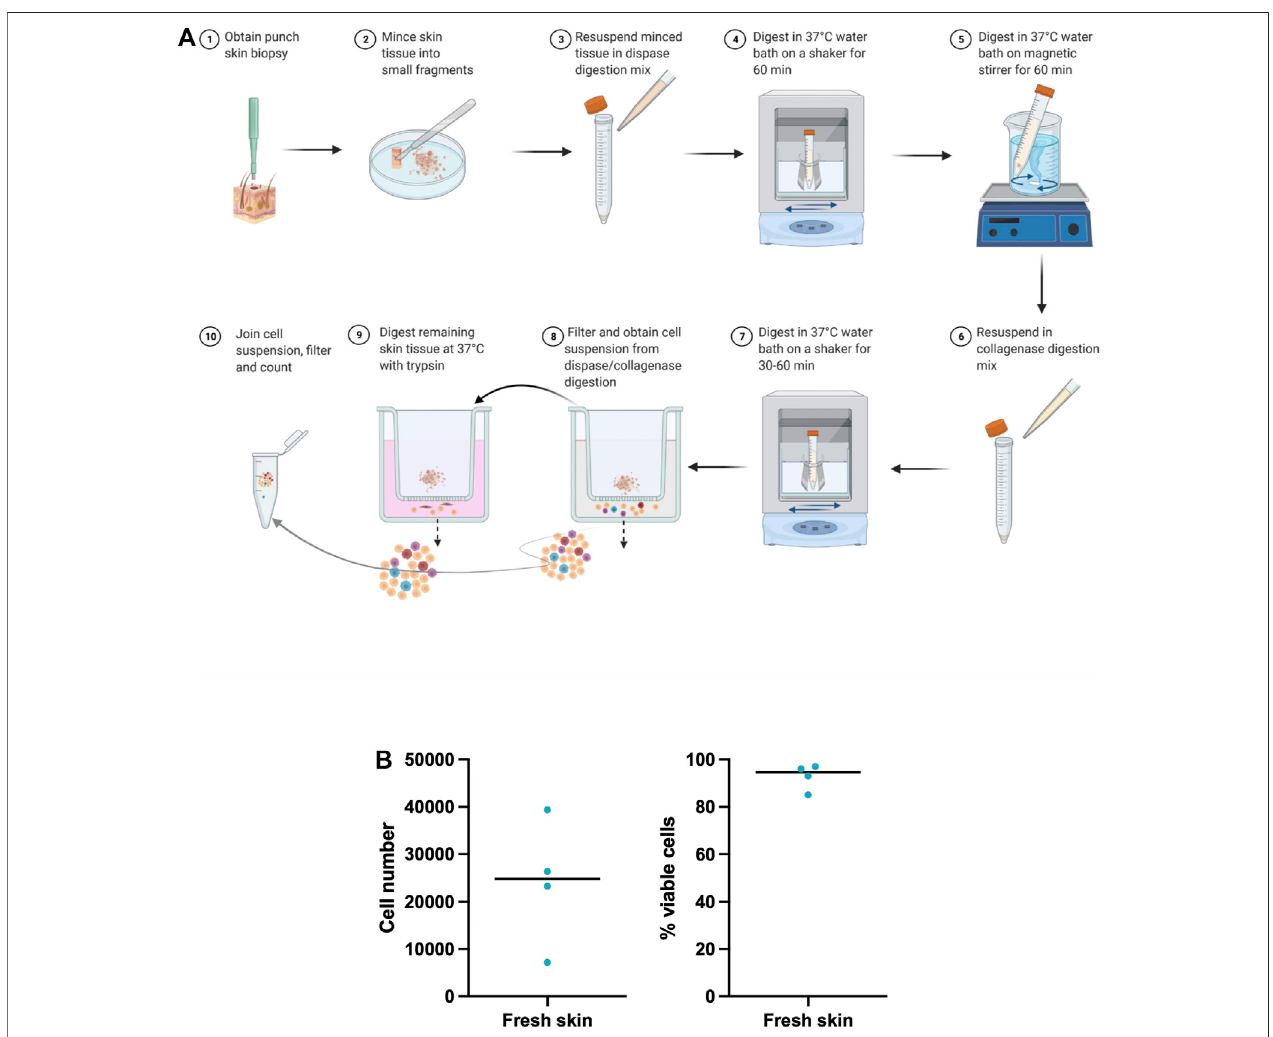
FIGURE 1 | Optimized skin dissociation protocol. (A) Graphic representation of the principal steps of our optimized skin dissociation protocol. Figure was created with BioRender.com (B) Number and viability of isolated skin cells from freshly processed skin biopsies. Shown is median.